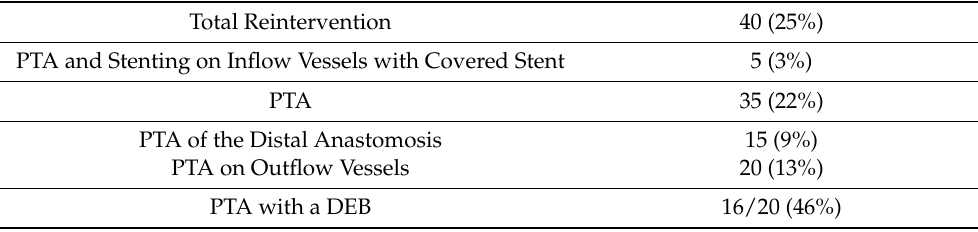
Table 3. Technical Data on Reintervention.